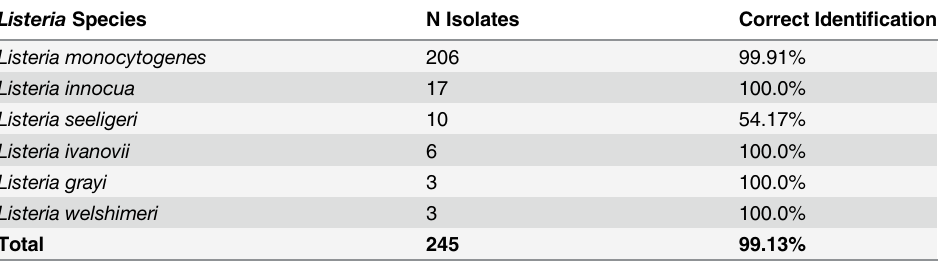
Table 1. Listeria species distribution and percentage of correctly identified spectra. Due to Listeria monocytogenes ’ role in foodborne illness, there are a disproportional number of these isolates tested.